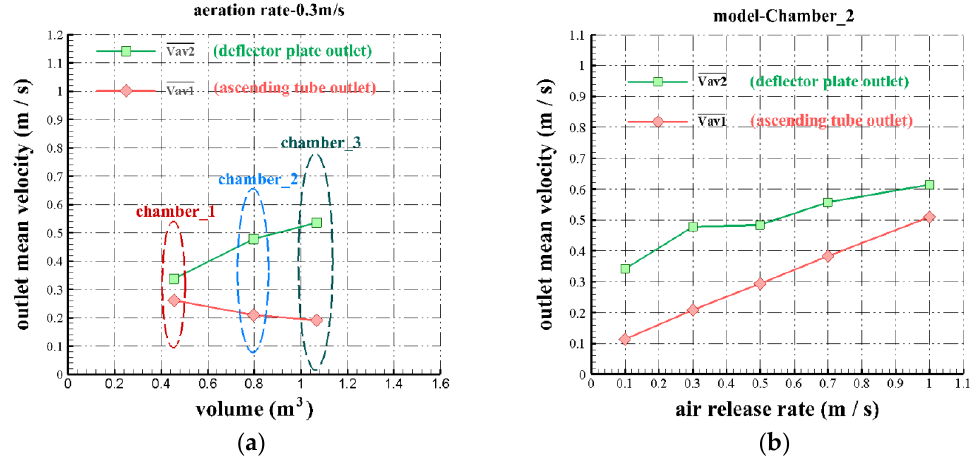
Figure 12. Comparison diagram of the performance of the WLA. ( a ) Effect of air chamber volume on WLA performance. ( b ) Effect of air release rate on WLA performance.